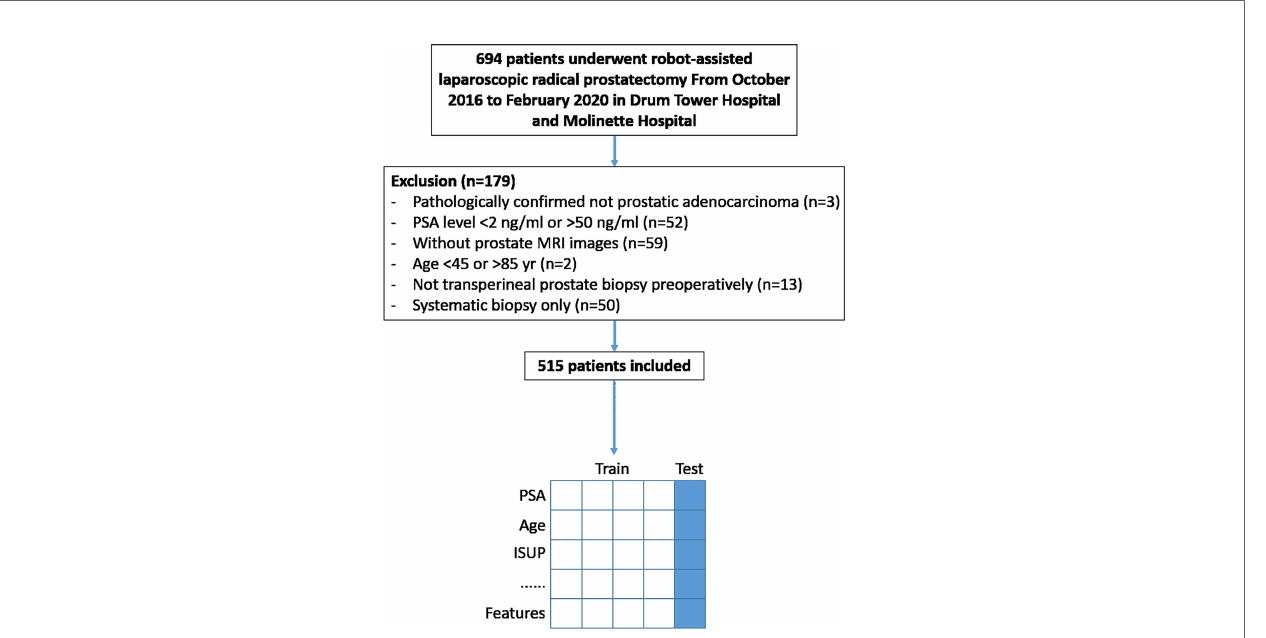
FIGURE 1 | Study fl owchart. Data from four out of fi ve included patients were trained for prediction model building and the rest for model